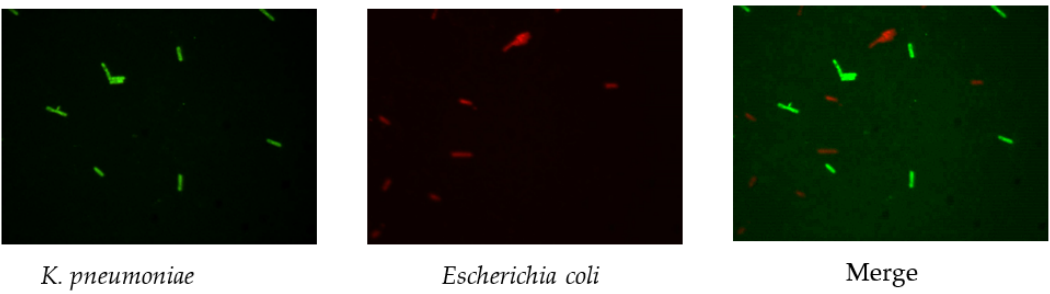
Figure 4. Detection of four coliform strains using the established FISH method under optimal conditions.